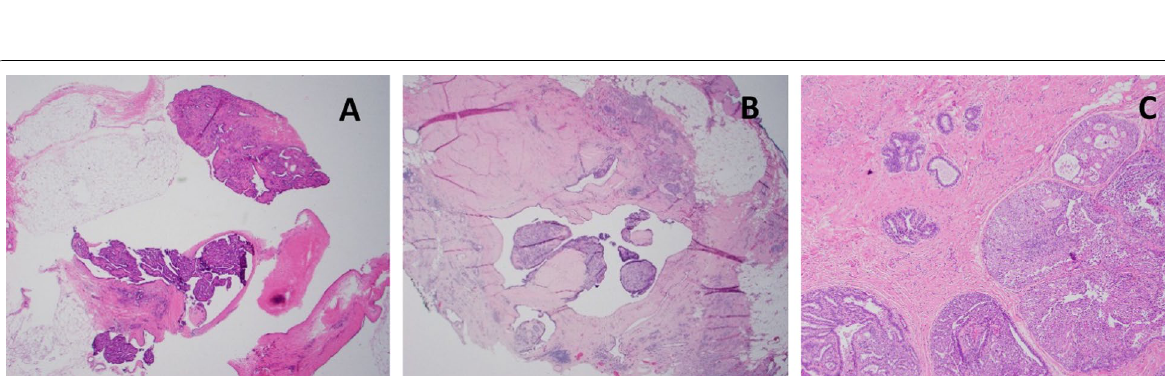
( A ). Excisional × ( B ). Cribriform ductal carcinoma in situ, low nuclear grade was ×